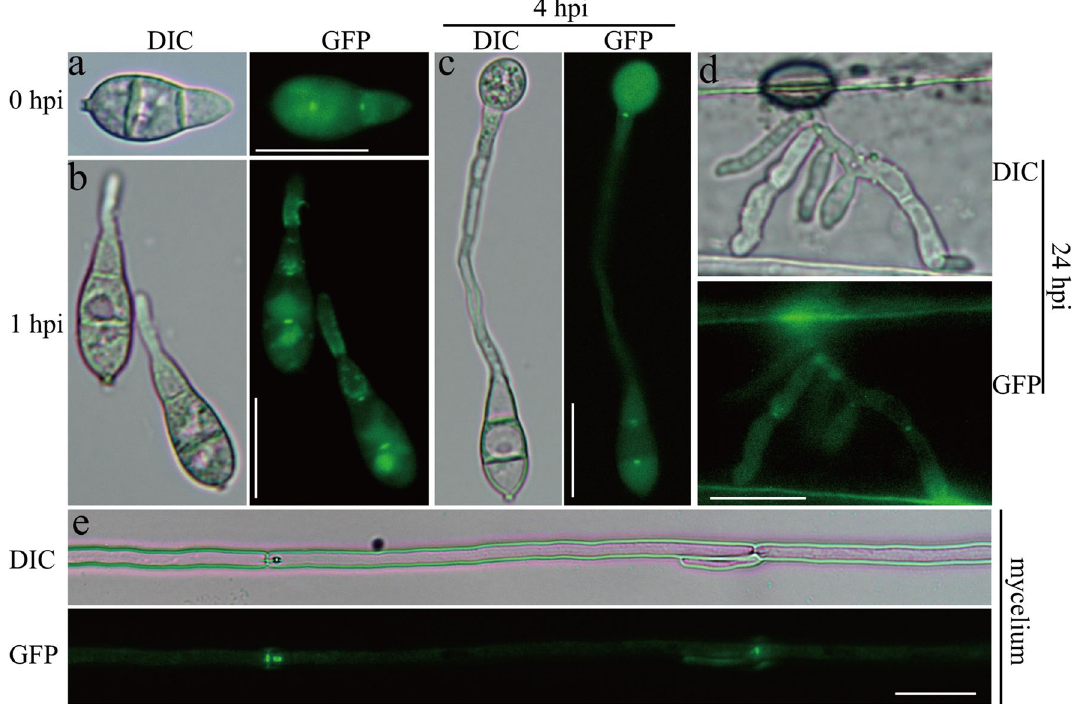
Fig. 5 Subcellular localization of MoB56‑GFP in Magnaporthe oryzae . MoB56‑GFP distributes into the cytoplasm and explicitly assembles as a dot‑like structure in the center of septa in mycelia, conidia, primary appressoria and infection hyphae. Assembly of MoB56‑GFP in conidia was observed at 1 h post‑inoculation (hpi). Bars 20 =